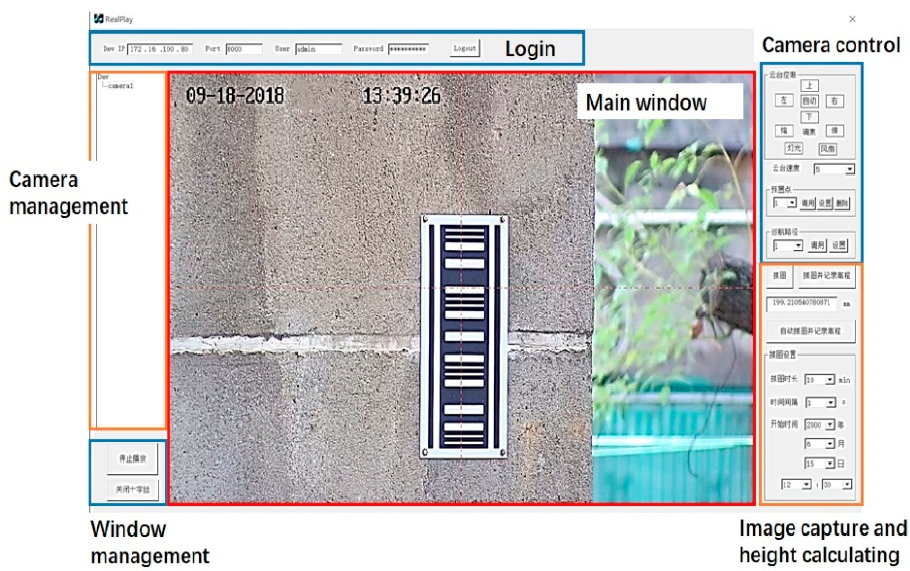
Figure 13. The interface of the software for the barcode recognition and height calculation.